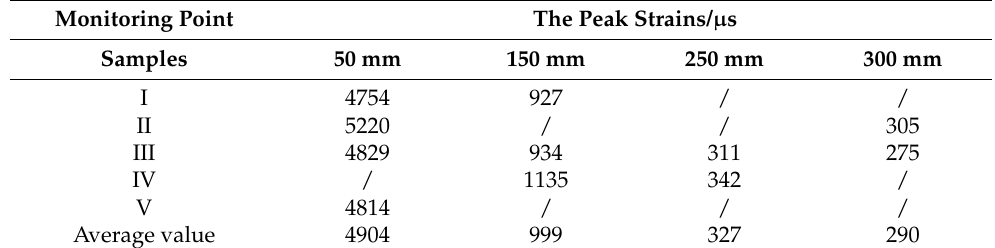
Figure 14. HPAB experiments: ( a ) simulated coal samples; ( b ) laboratory experiment. Table 5. The peak strains at each measurement point.